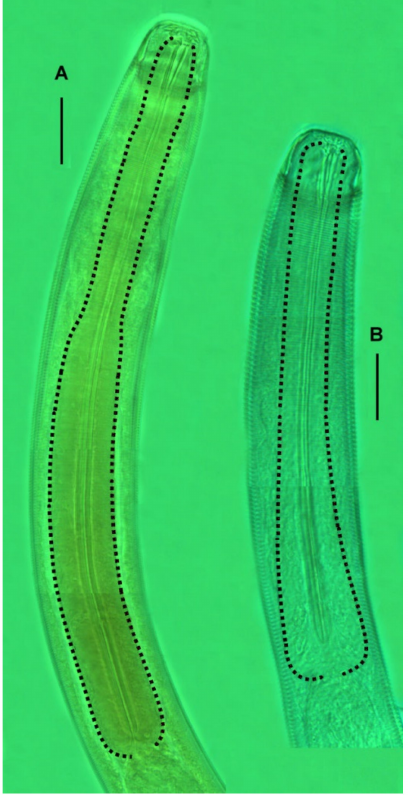
Figure 2. Pharynx outline (dash lined) in two varieties initially recognized: ( A ) Acanthopharynx 1, pharynx consists of two distinct parts, anterior narrow and posterior wide; ( B ) Acanthopharynx 2, pharynx elongate conoid. Scale bars 20 µ